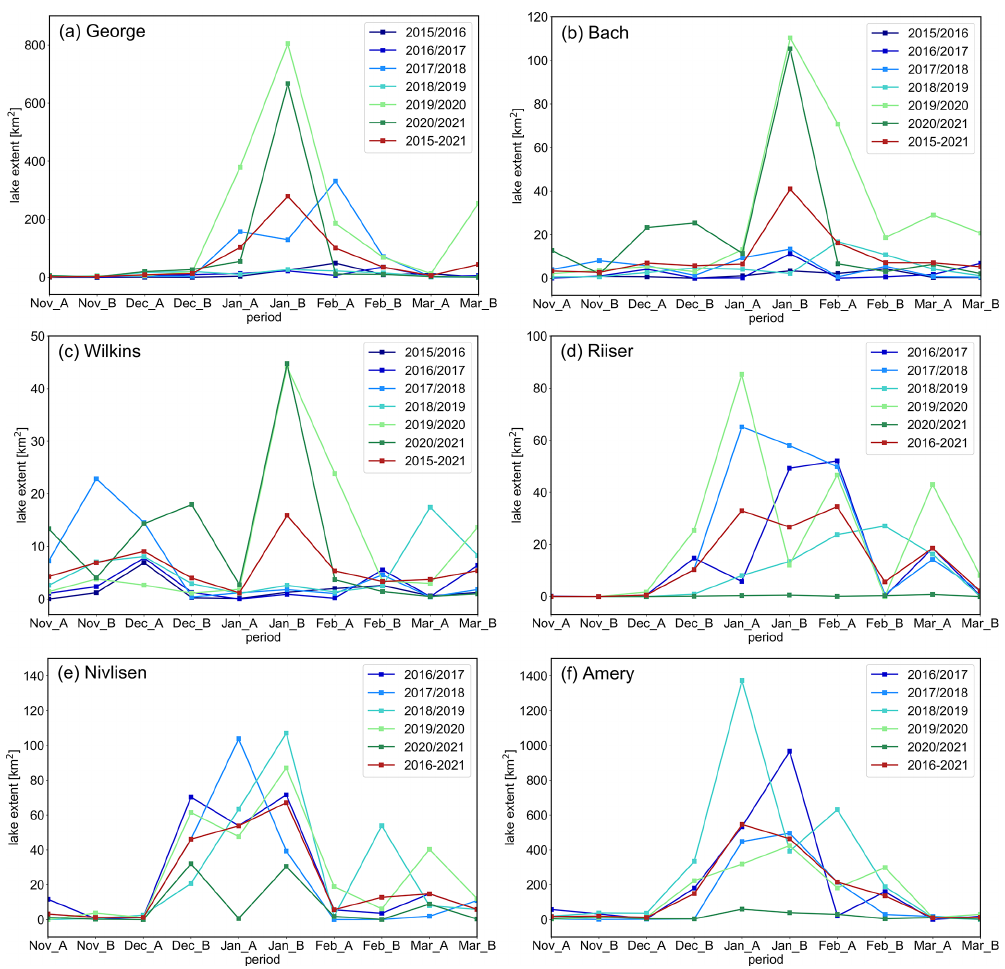
Figure 3. Supraglacial lake extent dynamics over (a) George VI, (b) Bach, (c) Wilkins, (d) Riiser-Larsen, (e) Nivlisen and (f) Amery ice shelves, as computed with Sentinel-1 and Sentinel-2 imagery. The red line in each plot represents the dynamic long-term mean 2015–2021 for each respective bi-weekly time interval. The periods represent the bi-weekly time intervals during a melting season, with “A” representing the first half of a given month and “B” the second